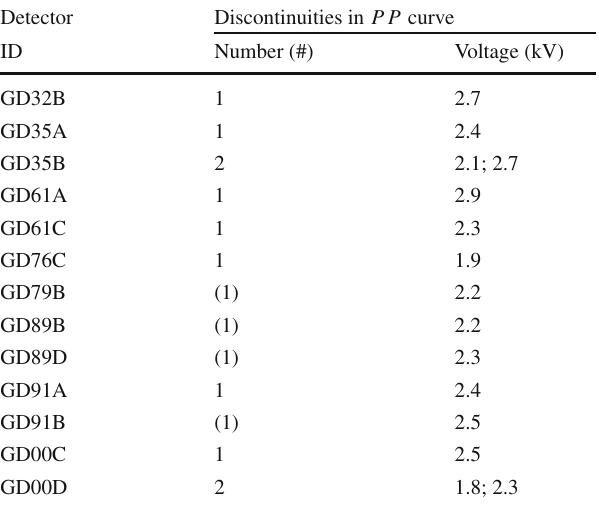
Table 1 List of Gerda Phase II BEGe detectors that are affected by the single or double ‘bubble depletion’ effect. Parentheses around the number of discontinuities denote a less intense effect